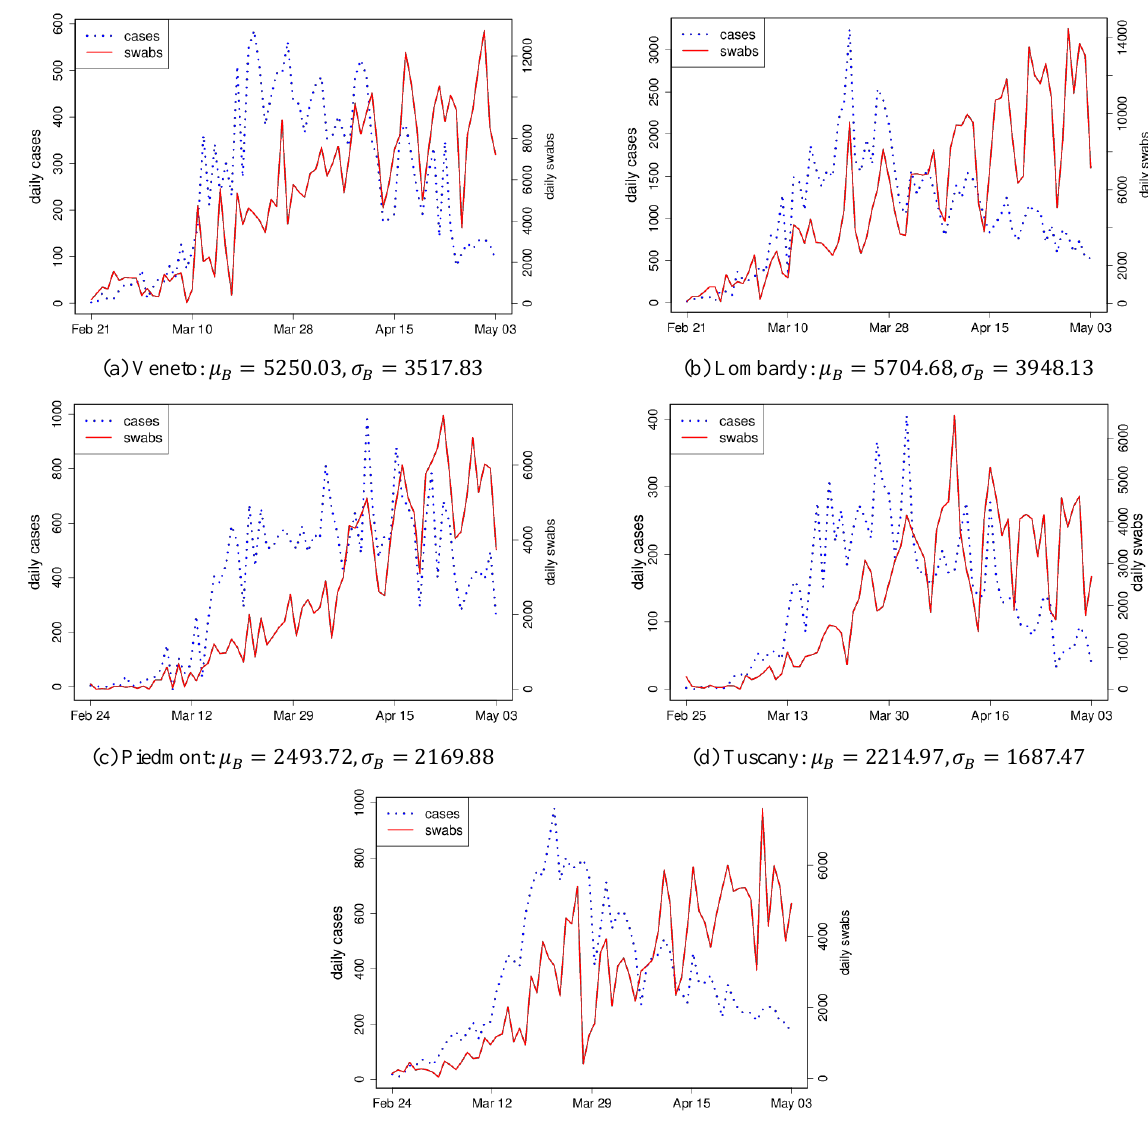
Figure 5. Daily number of confirmed cases and daily number of swabs processed in the five regions. 𝝁 𝑩 and 𝝈 𝑩 correspond to the average and standard deviation, respectively, of the swab time series (see Equation 11). Table 3. Veneto. Estimates, asymptotic standard errors and 95% mCIs for the parameters of the DMPsw (9)+(11). Parameter Estimate Standard Error Confidence Interval 𝑚 19932.21